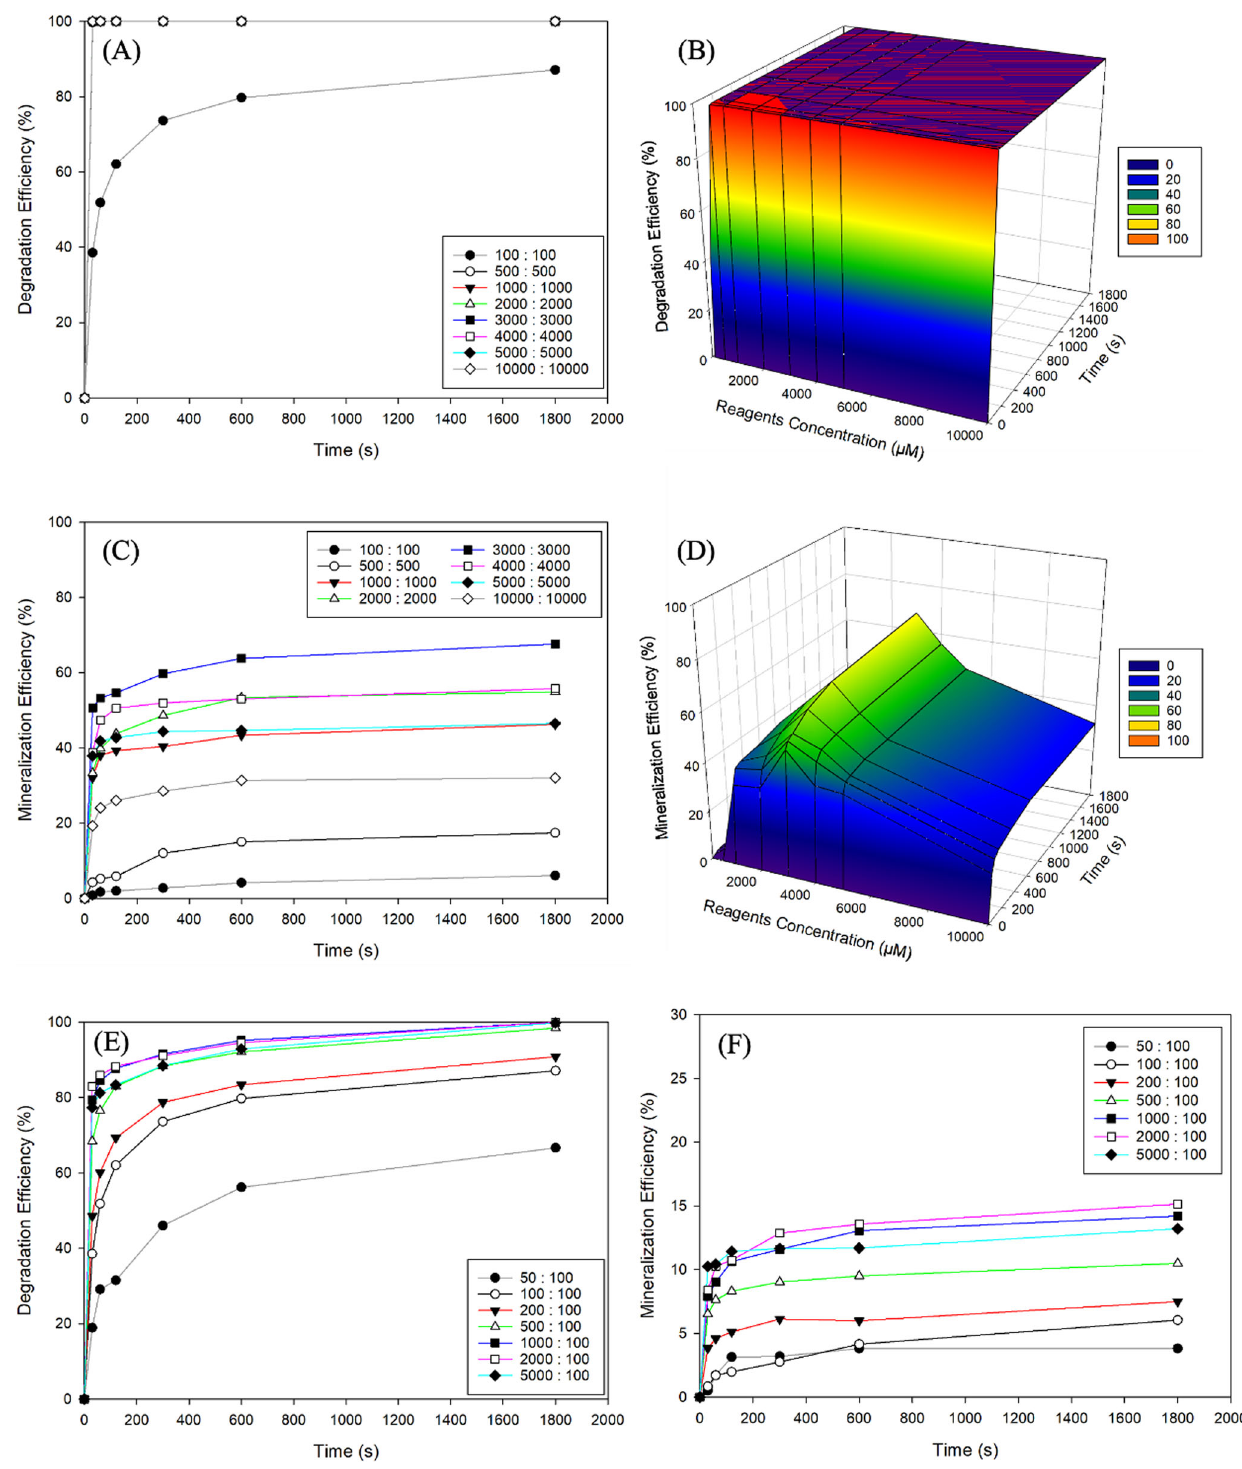
Fig. 1 The removal of CBZ by the Fenton process. The degradation ( A , B ) and mineralization ( C , D ) ef fi ciencies with the fi xed reagents ratio of 1:1. The degradation ( E ) and mineralization ( F ) ef fi ciencies in various H 2 O 2 concentrations. In graph ( A ), the ef fi ciency reaches 100% at concentrations above 500 μ contaminant CBZ appeared to be a two-stage degradation. By using the linear regression method with the least square analysis, the second-order kinetic was found best fi t with the data both in the present study, the observed degradation of the target Phases I and II. The two kinetic rate constants were obtained by